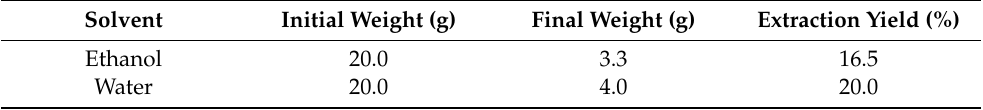
Table 1. Extraction yields of Eucalyptus Camaldulensis crude extract with two different